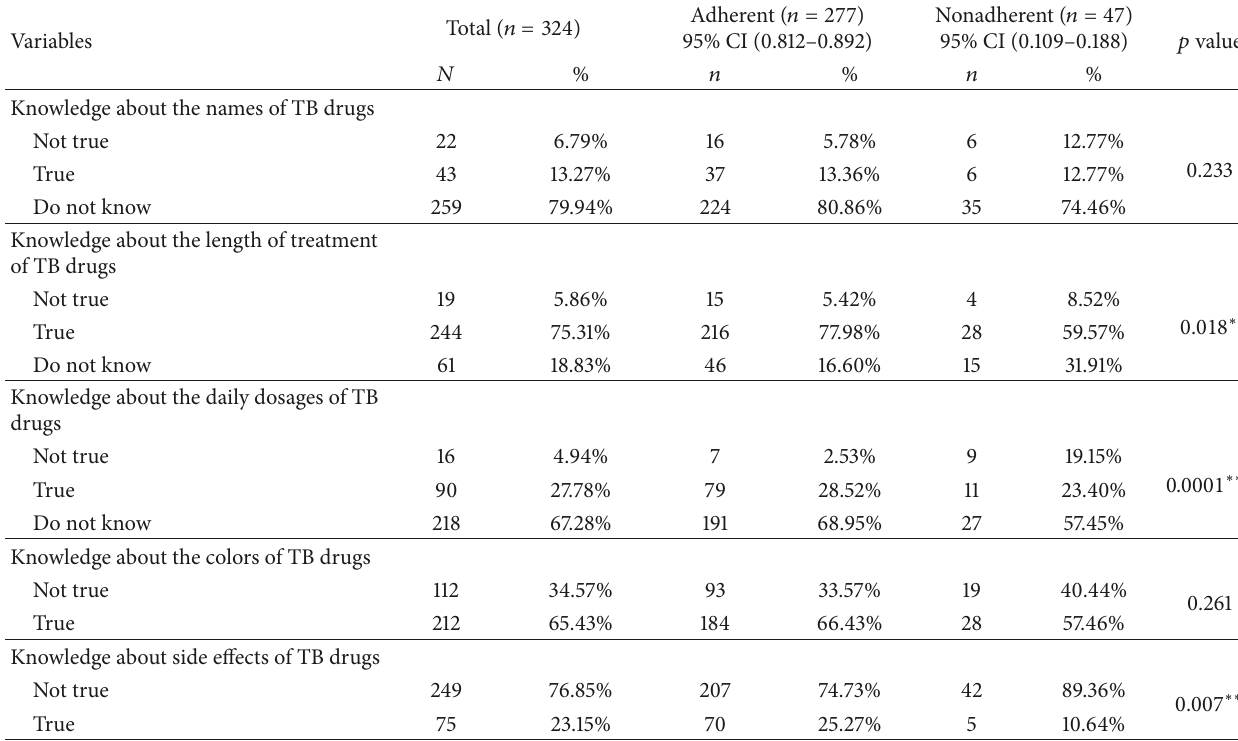
Table 3: Knowledge for TB